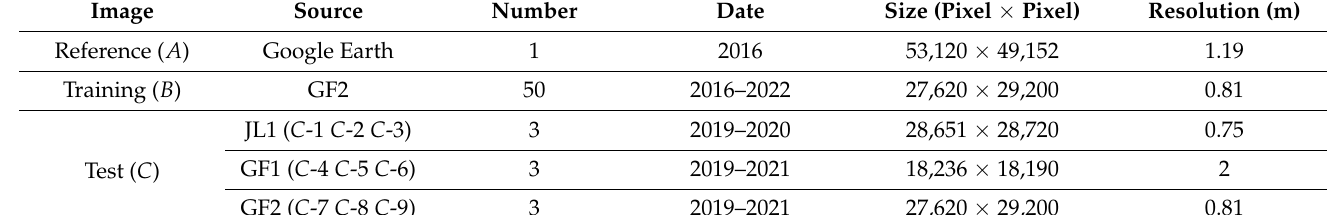
Table 3. Information for the data set.